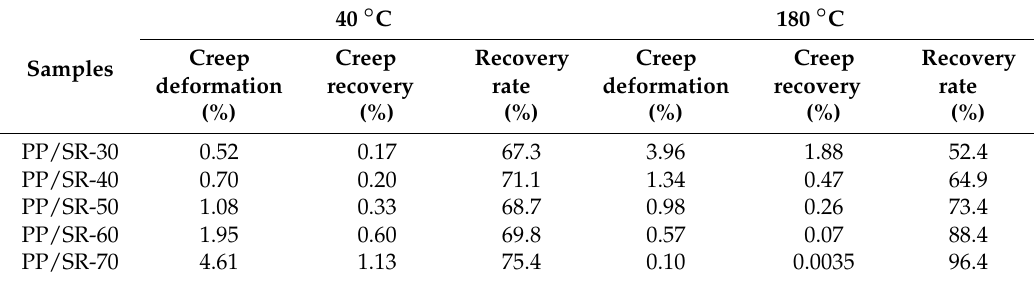
Figure 6. Creep deformation and its recovery behavior of polypropylene (PP)/silicone rubber (SR) thermoplastic vulcanizates (TPVs) at ( A ) 40 ◦ C and ( B ) 180 ◦ C. Table 2. Creep deformation, creep recovery and recovery rate values of polypropylene (PP)/silicone rubber (SR) thermoplastic vulcanizates (TPVs) at 40 and 180 °C .